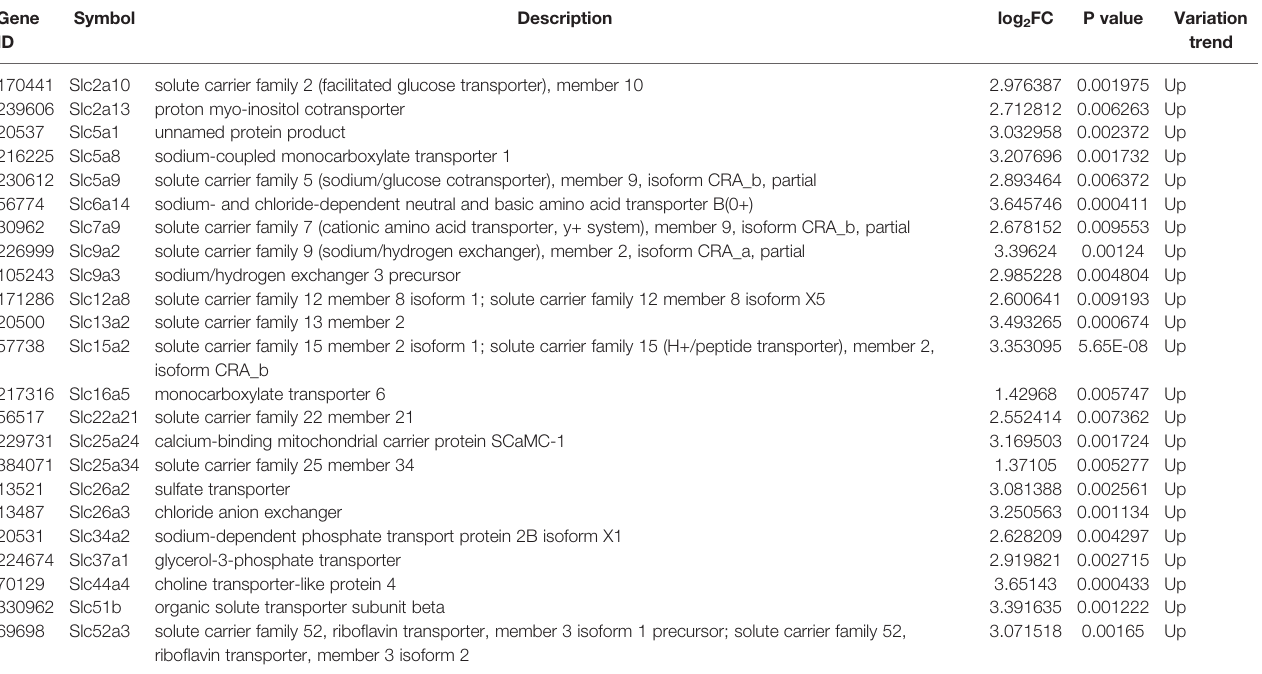
TABLE 2 | Slc transporters DEGs in liver compared between HFD+MET group and HFD group (\log2FC\ ≥ 1 and P<0.01). Gene Symbol ID